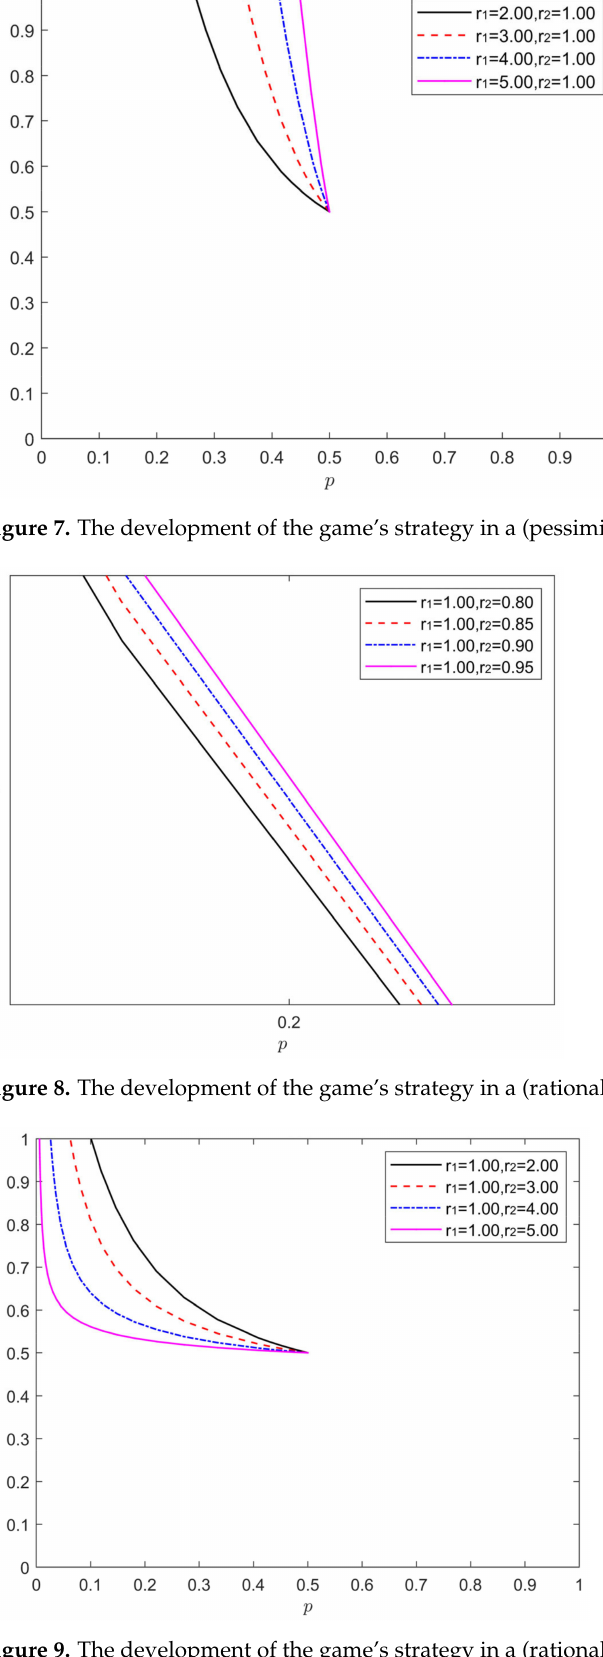
Figure 9. The development of the game’s strategy in a (rational, pessimistic)